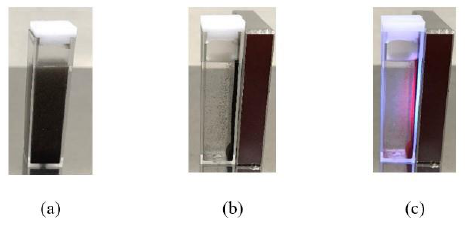
Figure 1. Photo images of FOASET NC, ( a ) at ambient temperature, ( b ) under the influence of a magnet, and ( c ) under the influence of magnet and light excitation.